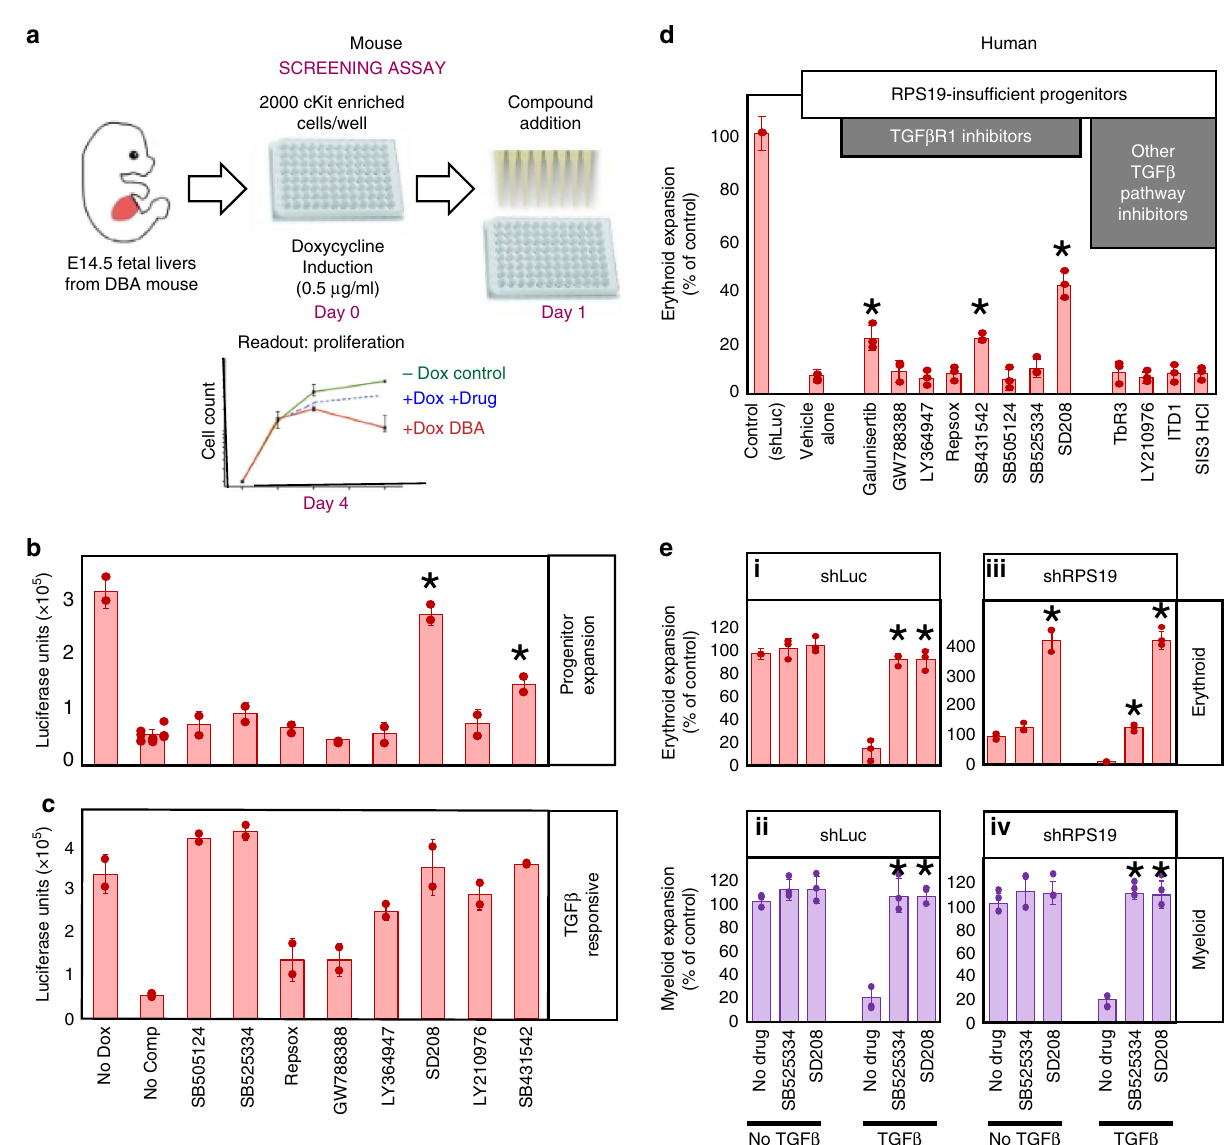
Fig. 1 TGF β R1 inhibitors that improve erythropoiesis also inhibit NLK activity. a Schematic of assay utilized to screen compounds for effects on erythroid progenitor cell expansion. Lin-Kit + fetal liver cells were obtained from mouse embryos expressing tet-on shRNA against RPS19, at day E14.5-15.5. Cells were plated at 2000 cell per well in 96-well plates in the presence or absence of doxycycline. Relative amounts of live cells were quanti fi ed by luciferase- based Cell titer-Glo ® assay. b TGF β R1 inhibitors were assessed for their ability to increase cell expansion in RPS19-insuf fi ency. As a control, vehicle alone (no doxycycline) is represented at the far left while all other samples were treated with doxycycline to induce RPS19-insuf fi ciency. c Kit + erythroid progenitors were grown in the absence of doxycycline and in the presence of 10 µ M of indicated compound. In addition, cells were treated with 5 ng/ml of TGF β 1 for 5 days before being subjected to Cell titer-Glo ® assay. d Differentiating cord blood CD34 + progenitors were transduced with shRNA against luciferase or RPS19 and treated with inhibitors at working concentrations for TGF β inhibition every three days. Cells were counted and CD235 + erythroid cells were assessed by fl ow cytometry after 15 days. e Cord Blood CD34 + progenitors were transduced with shRNA against luciferase (i and ii) or RPS19 (iii and iv) differentiated in erythroid media for 15 days alone, or the indicated combinations of 5 ng/ml TGF β 1, SB525334 or SD208 at 5 µ M. Cells were counted and CD235 + erythroid (i and iii) and CD11b + myeloid cell (ii and iv) percentages were determined by fl ow cytometry. The number of erythroid or myeloid cells is expressed as a percentage of the number of that lineage with no cytokine or drug treatment. Bars represent means ± SD with individual data points overlaid. n = 3 independent experiments performed in triplicate. Statistics: two-tailed Student ’ s t test, signi fi cant * p < 0.05. Also see Supplementary Fig. 1. Erythroid expansion is depicted in red while myeloid is in purple. Source data are provided as a Source Data fi